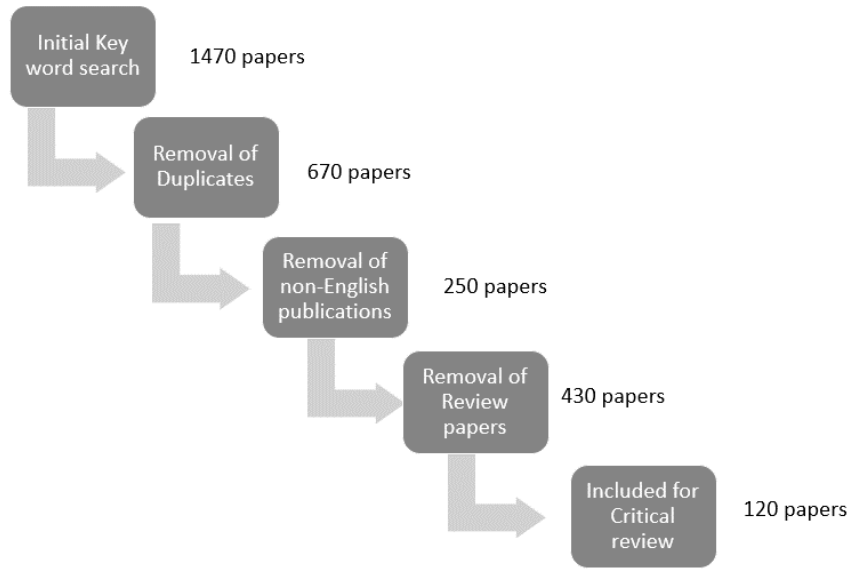
Figure 1. Detailed process of screening for the most relevant papers related to our research ques- tions.